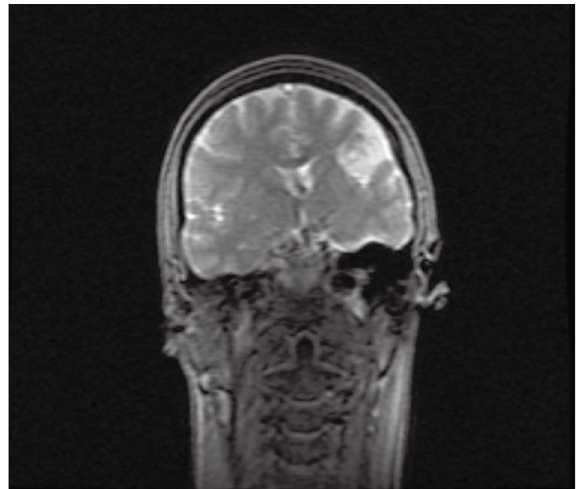
Figure 2: Coronal T2-weighted view showing the fronto-opercular porencephalic cyst with CSF